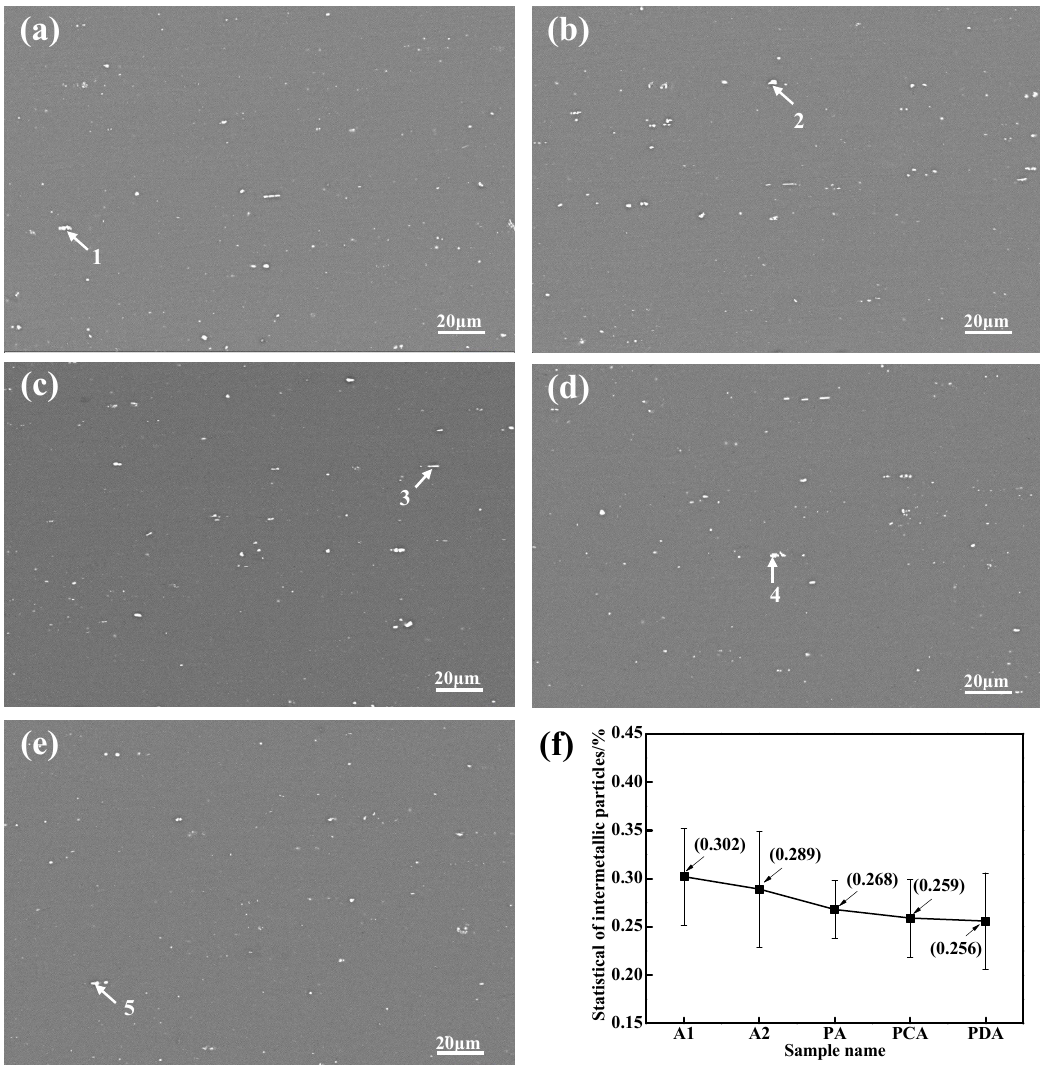
Figure 5. The scanning electron microscopy (SEM) micrographs of intermetallic particles in the five aged samples: ( a ) A1, ( b ) A2 ( c ) PA, ( d ) PCA, ( e ) PDA; ( f ) Area fraction of intermetallic particles (IMPs). Table 4. Chemical composition of intermetallic particles in Figure 5 (wt%).